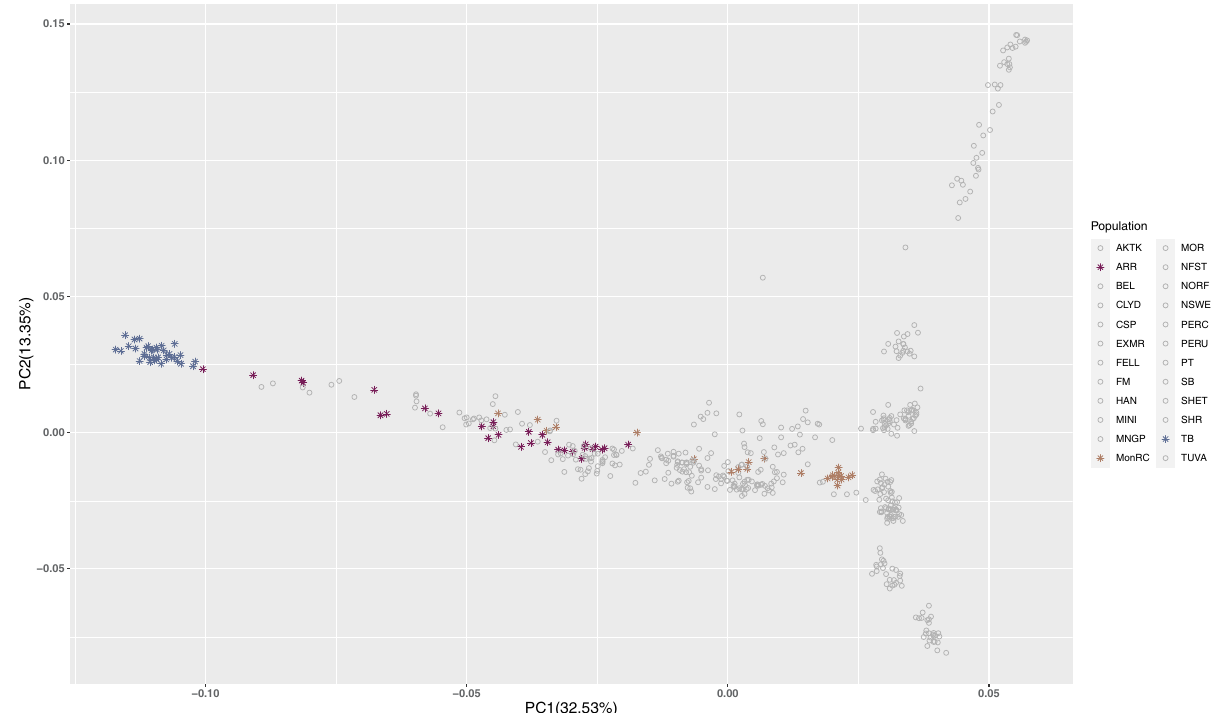
Fig. 1 Principal component analysis (PCA) plot for n = 574 horses using 36,767 genome-wide SNPs. Thoroughbreds (TB), Arabian (ARR) and Mongolian Racing (MonRC) are highlighted — TB (blue), ARR (purple), MonRC (Fig. 1) and an admixture structure plot (Fig. 2). In the PCA plot of PC1 and PC2, Thoroughbreds were tightly clustered with no overlap with any other breed, while Arabian and Mongolian Racing horses were more loosely distributed across PC1 (32.5% of